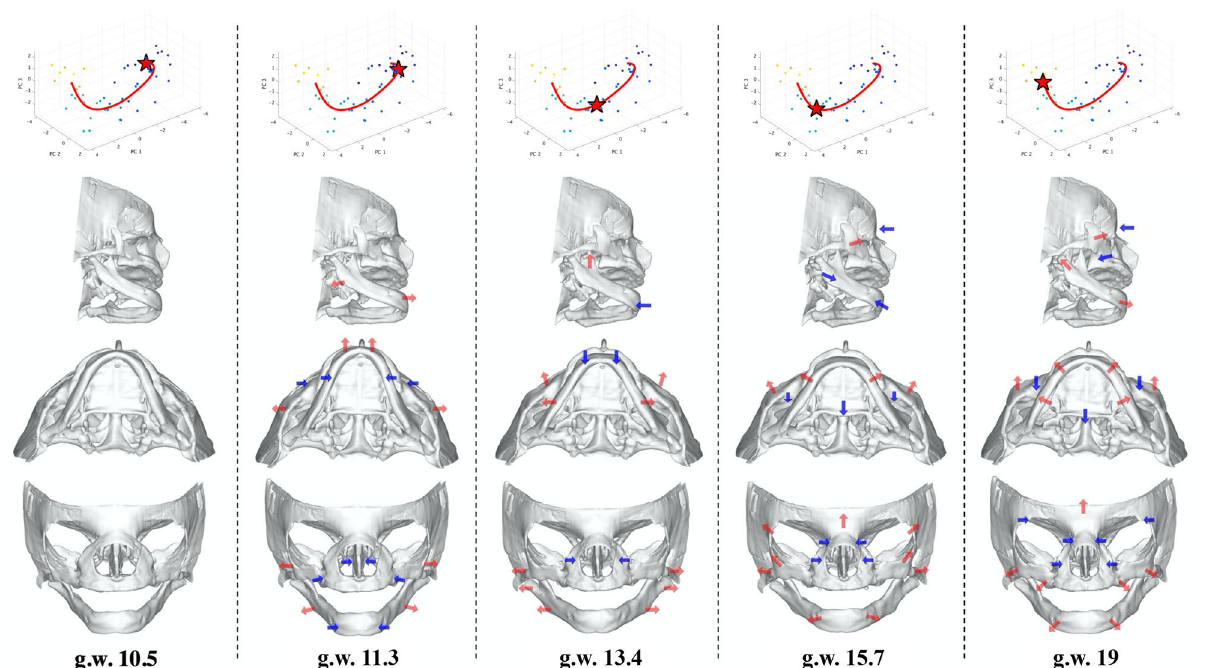
Figure 3. Facial skeletal morphogenesis along the growth trajectory. The PC plots in the top row depicts the distribution of specimens along PCs 1, 2 and 3. Colored dots represent individual specimen (blue = youngest and yellow = oldest) and the 3 dimensional red line indicates the growth trajectory from youngest to oldest. Columns 1–5 depict the skull shape changes from an infero-lateral, inferior and frontal views (2nd, 3rd and 4th rows respectively). The “red star” in each PC plot corresponds to the estimated gestation week during which significant changes in facial shape can be noted, as represented by the bend in the red line. Red arrows indicate relative outward and forward growth, while blue arrows indicate relative inward in backward growth in specific areas of the fetal